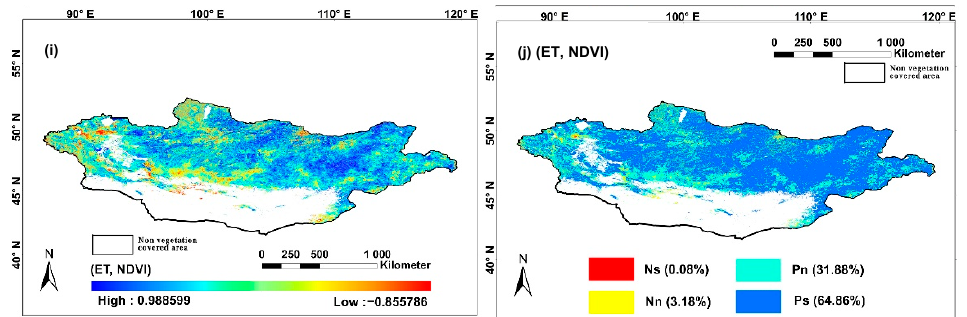
Figure 7. Spatial distributions of the partial correlation coefficients between climate factors and ET in the growing season from 2001 to 2020: ( a , b ) Pre, ( c , d ) Tem, ( e , f ) Nsr, ( g , h ) Swl, and ( i , j ) NDVI. The percentages of Ns (significant negative correlation), Nn (nonsignificant negative correlation), Pn (nonsignificant positive correlation), and Ps (significant negative correlation) values are shown.